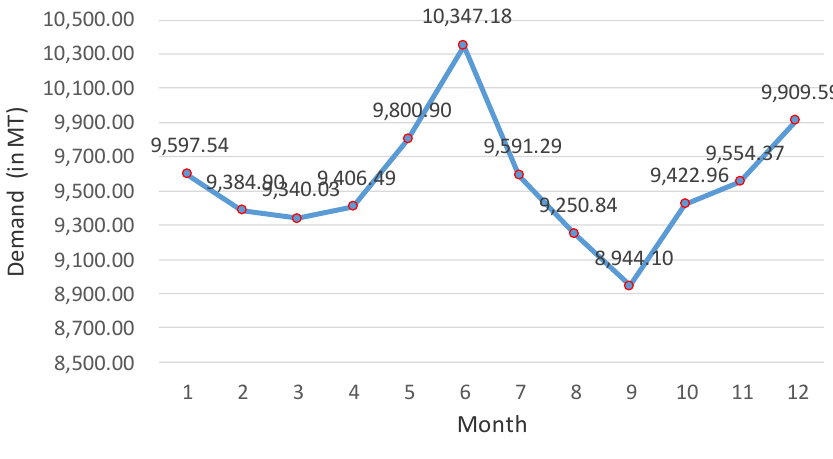
Fig. 4. Fluctuation demand of frozen meat in Indonesia with year period of